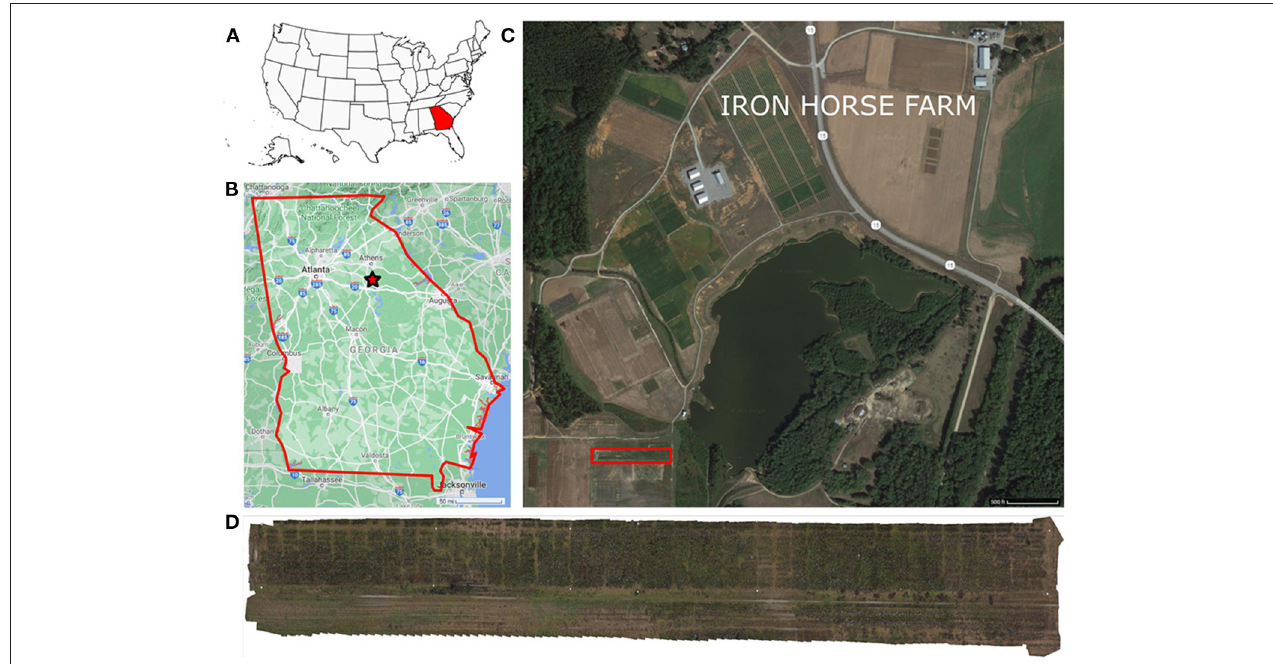
FIGURE 1 | Experimental field location. The experiment was conducted in the Iron Horse Farm, Greene County, GA, U.S. (A) Location map of Georgia, marked in red, in the U.S., (B) General map of Georgia, the experiment location is marked with a red star, (C) Iron Horse Farm aerial view (Greene County, GA), the specific location of the experimental field is delimited by a red rectangle, (D) Field layout.